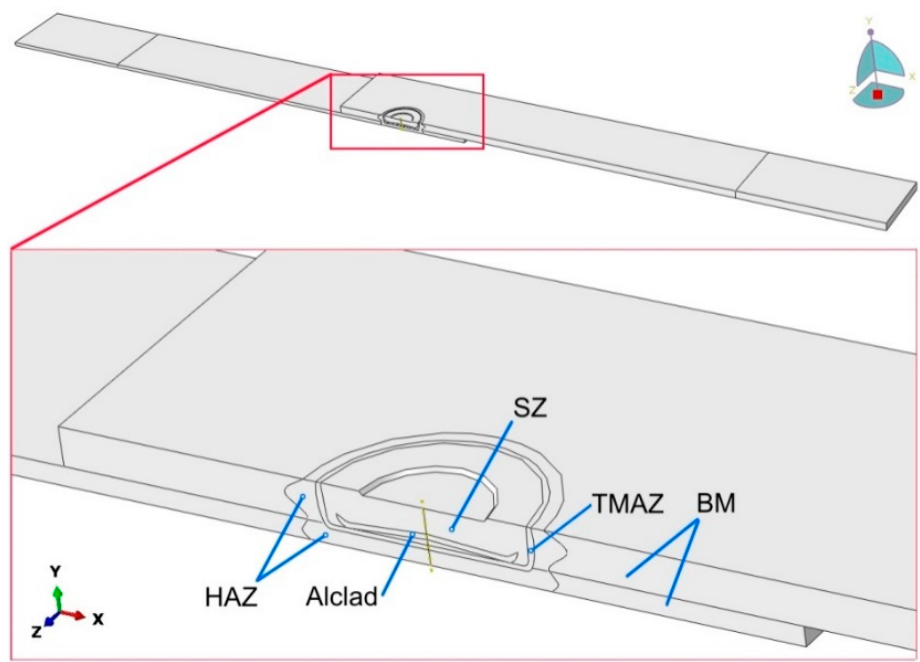
Figure 4. Model of the single-lap RFSSW joint.